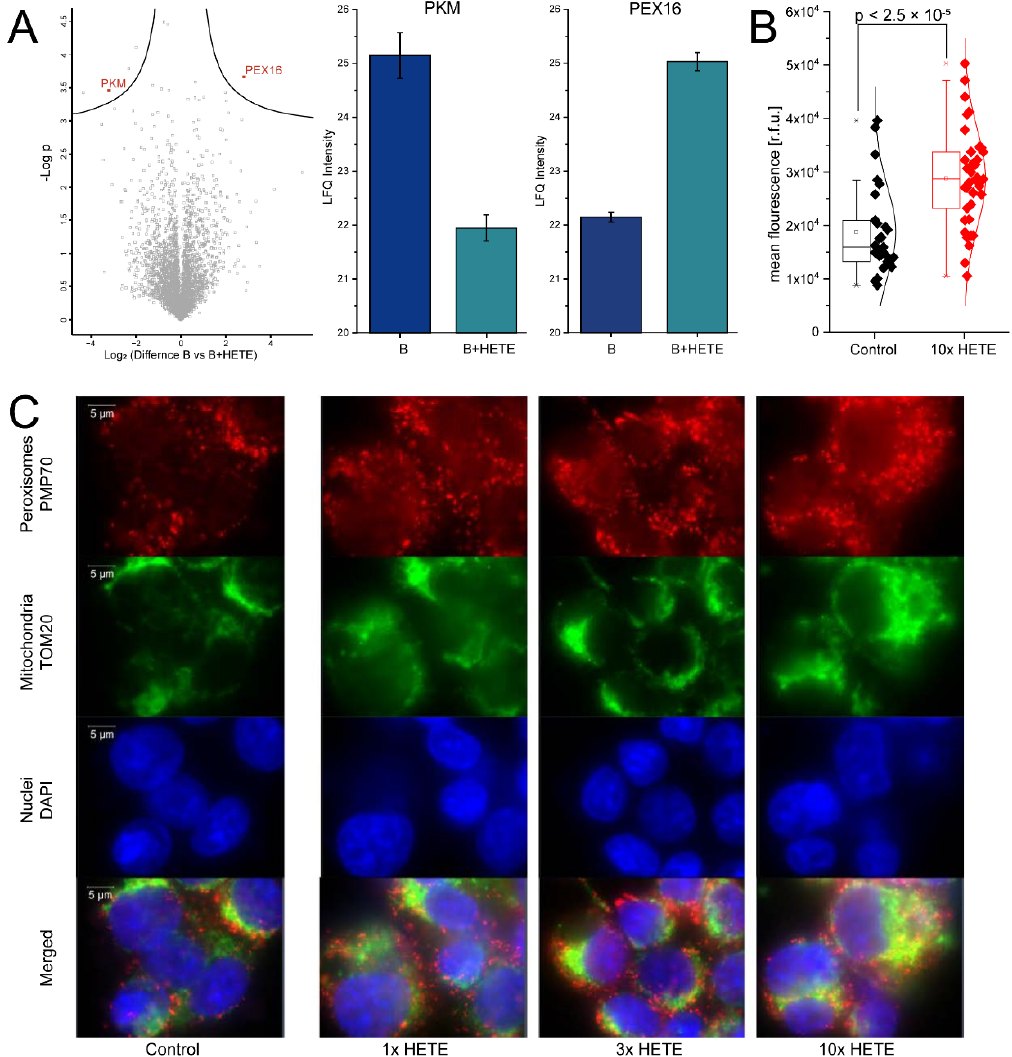
Figure 4. ( A ) Eicosanoid levels of 5-HETE and 15-HETE for FCS-B (before spiking), FCS-A and FCS- B after spiking with 5-HETE and 15-HETE. ( B ) Volcano plot for cytoplasmic proteins obtained from U937 cells after PMA differentiation when cultured in either FCS-B or FCS-B supplemented HETEs. Bar plots exemplify the significantly regulated proteins PKM and PEX16. ( C ) Immunofluorescence detection of peroxisomes (red, PMP70 antibody), mitochondria (green, TOM20 antibody) and nuclei (blue, DAPI) shown for control and increasing concentrations of supplemented HETEs (addition of 1, 3, or 10 times of the spiked HETE mix).